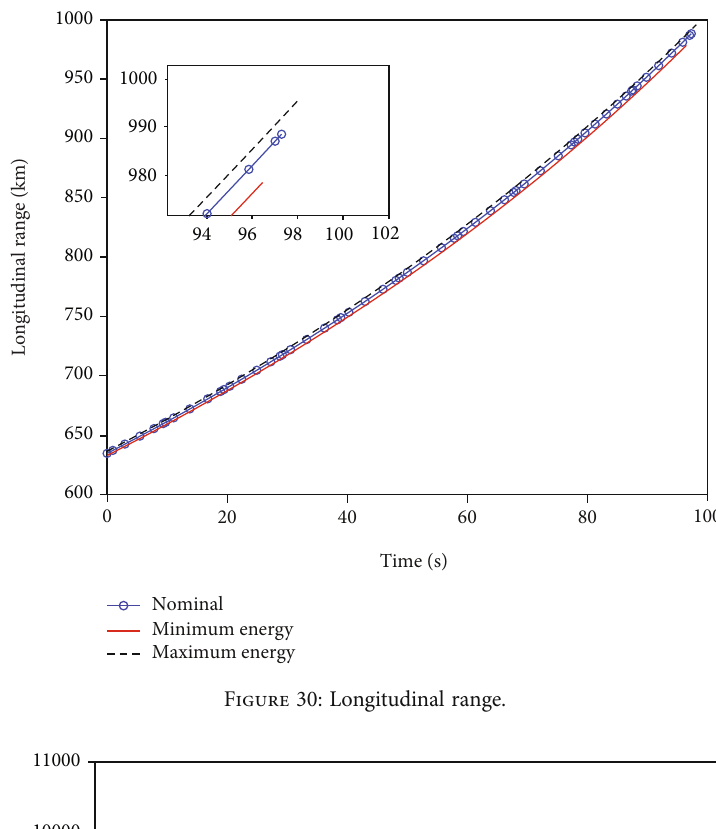
Figure 30: Longitudinal range.